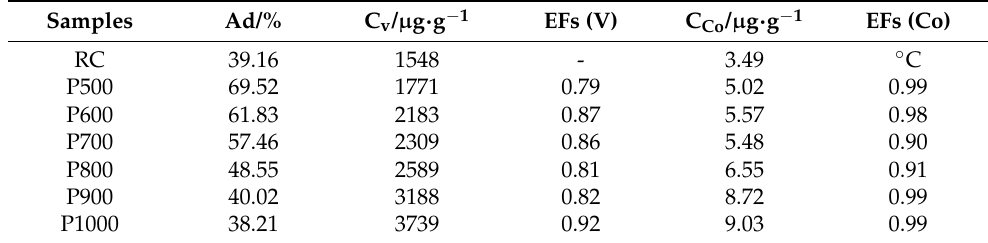
Table 4. Contents and enrichment factors (EFs) of V and Co in raw coal and combustion